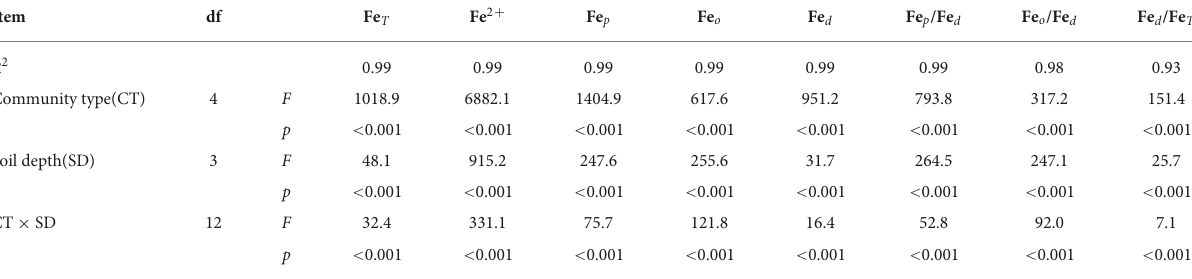
TABLE 2 Effects of community, soil depth as well as the interaction effects on iron based on general linear model (GLM) at α =